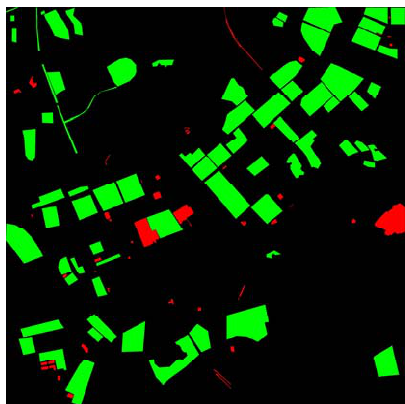
Figure 3. The reference map where red indicates change and green indicates nonchange.